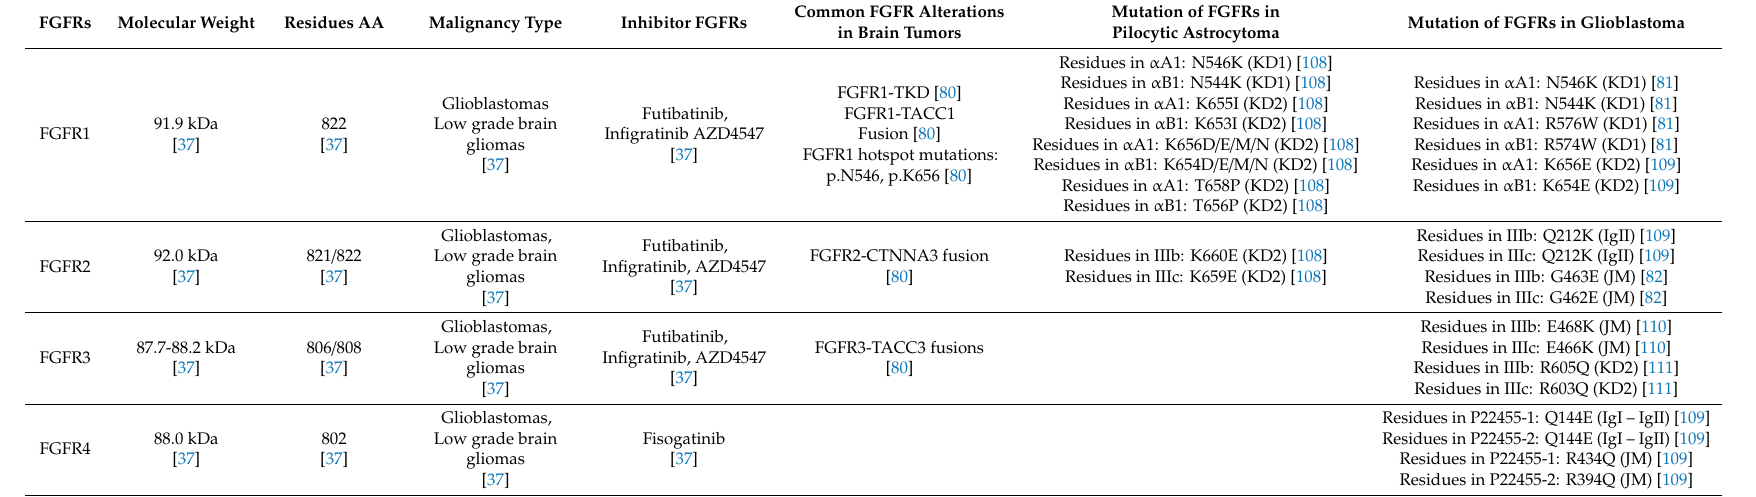
Table 1. The subtypes of FGFRs (FGFR1–4) with related molecular weight, residues AA, malignancy type, and inhibitor FGFRs are shown. In addition, i a framework of the common FGFR alterations in brain tumors is also provided. The main mutations of FGFRs, for pilocytic astrocytoma and glioblastoma, are illustrated in the last two